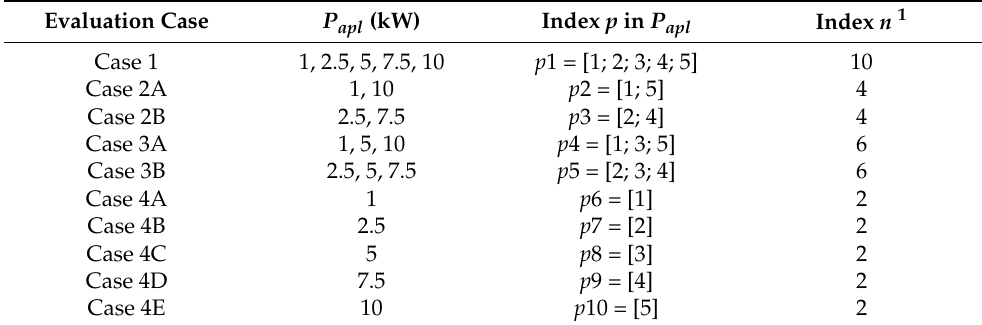
Table 1. Evaluation cases for the VRFB